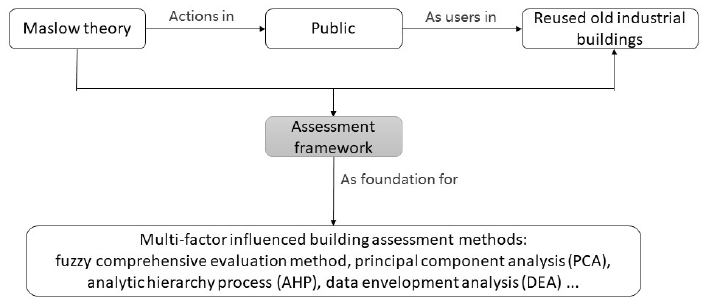
Figure 1. Brief mention of article patterns (by author, 2022).